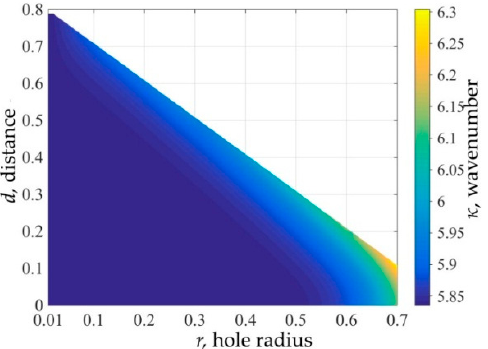
Figure 3. Dependence of the normalized wavenumber 𝜅 for the mode (11, 1, 𝑒 ) on the relative distance 𝑑 between the centers of the cavity and the hole and the relative radius 𝑟 of the hole.